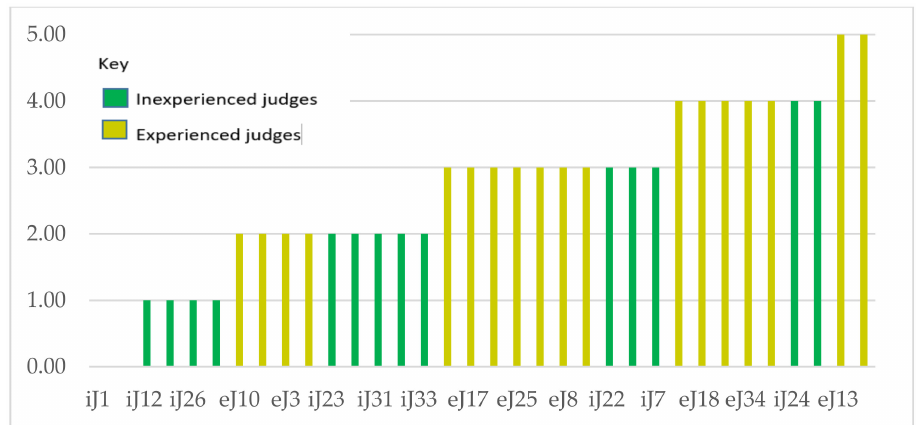
Figure 2. Number of correct judgements per experienced (ej) and inexperienced judge (ij) by 3-AFC Triangle Test for five compounds.